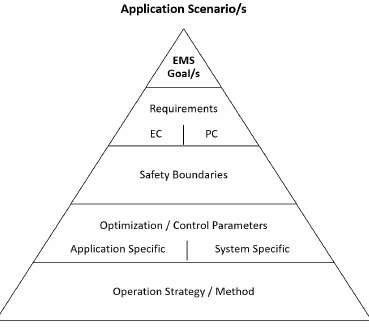
Figure 8. Methods of an energy management structure for